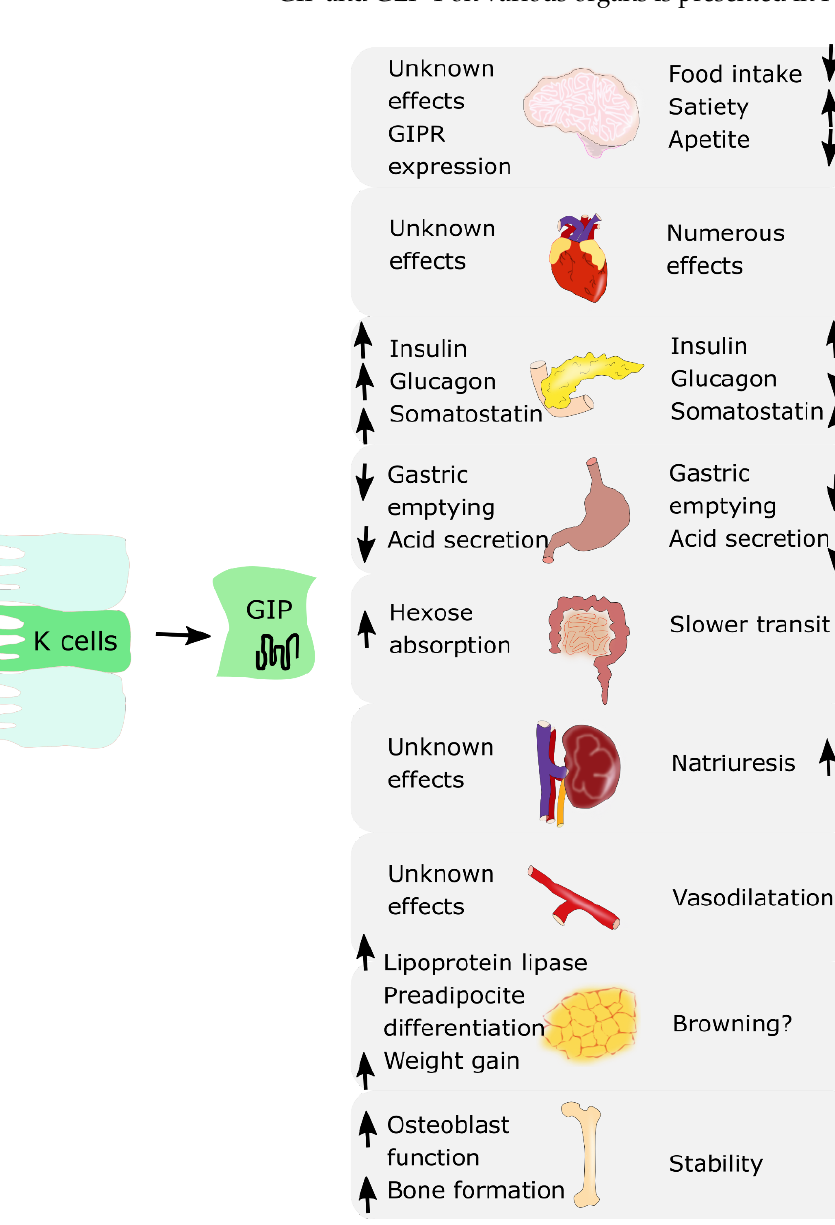
Figure 1. The summary of biological effects of glucose-dependent insulinotropic polypeptide (GIP) and glucagon-like peptide-1 (GLP-1) on various organs. ↑ : increase; ↓ : decrease.